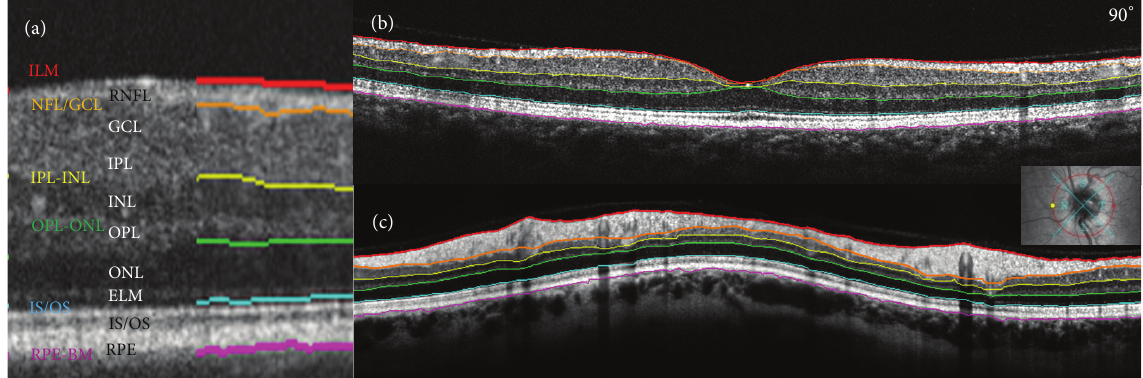
Figure 1: Spectral domain OCT automatic segmentation of retinal layers in the macula ((a) and (b)) and in the peripapillary area (c). In the macula the segmentation is performed on the linear scan (b) and in the peripapillary area on the circular scan around the optic disc (c). Six lines determine 5 retinal layers which from inside out are as follows: inner limiting membrane + nerve fibre layer (ILM + RNFL); ganglion cell layer + inner plexiform layer (GCL + IPL); inner nuclear layer + outer plexiform layer (INL + OPL); outer nuclear layer + external limiting